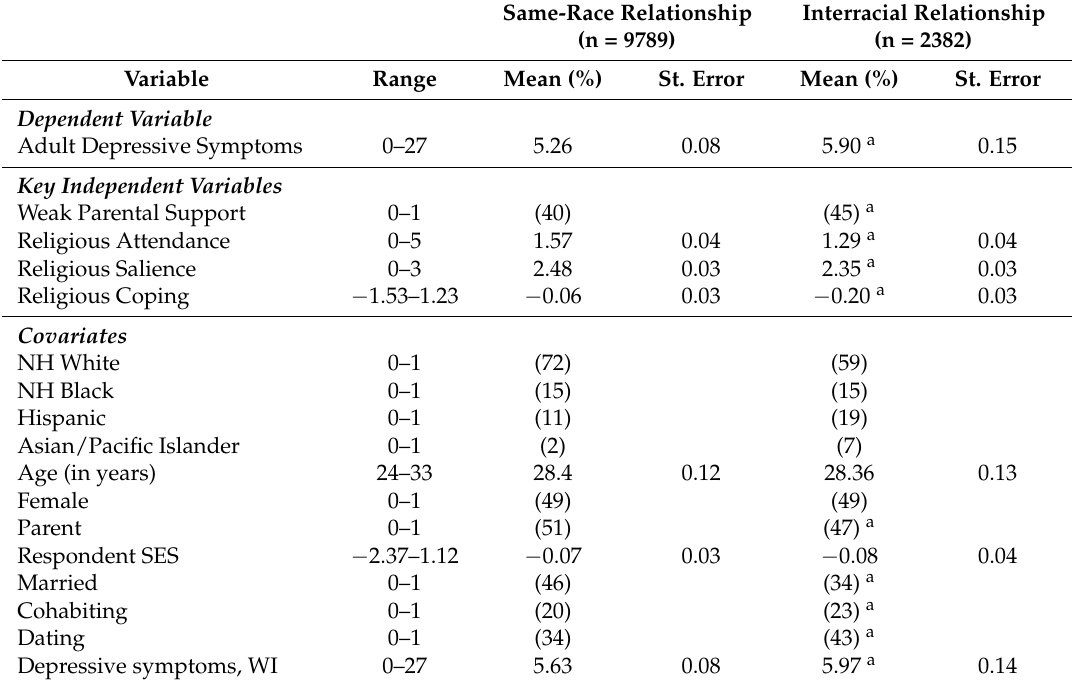
Table 1. Sample Characteristics by Same-race and Interracial Relationship, Add Health a